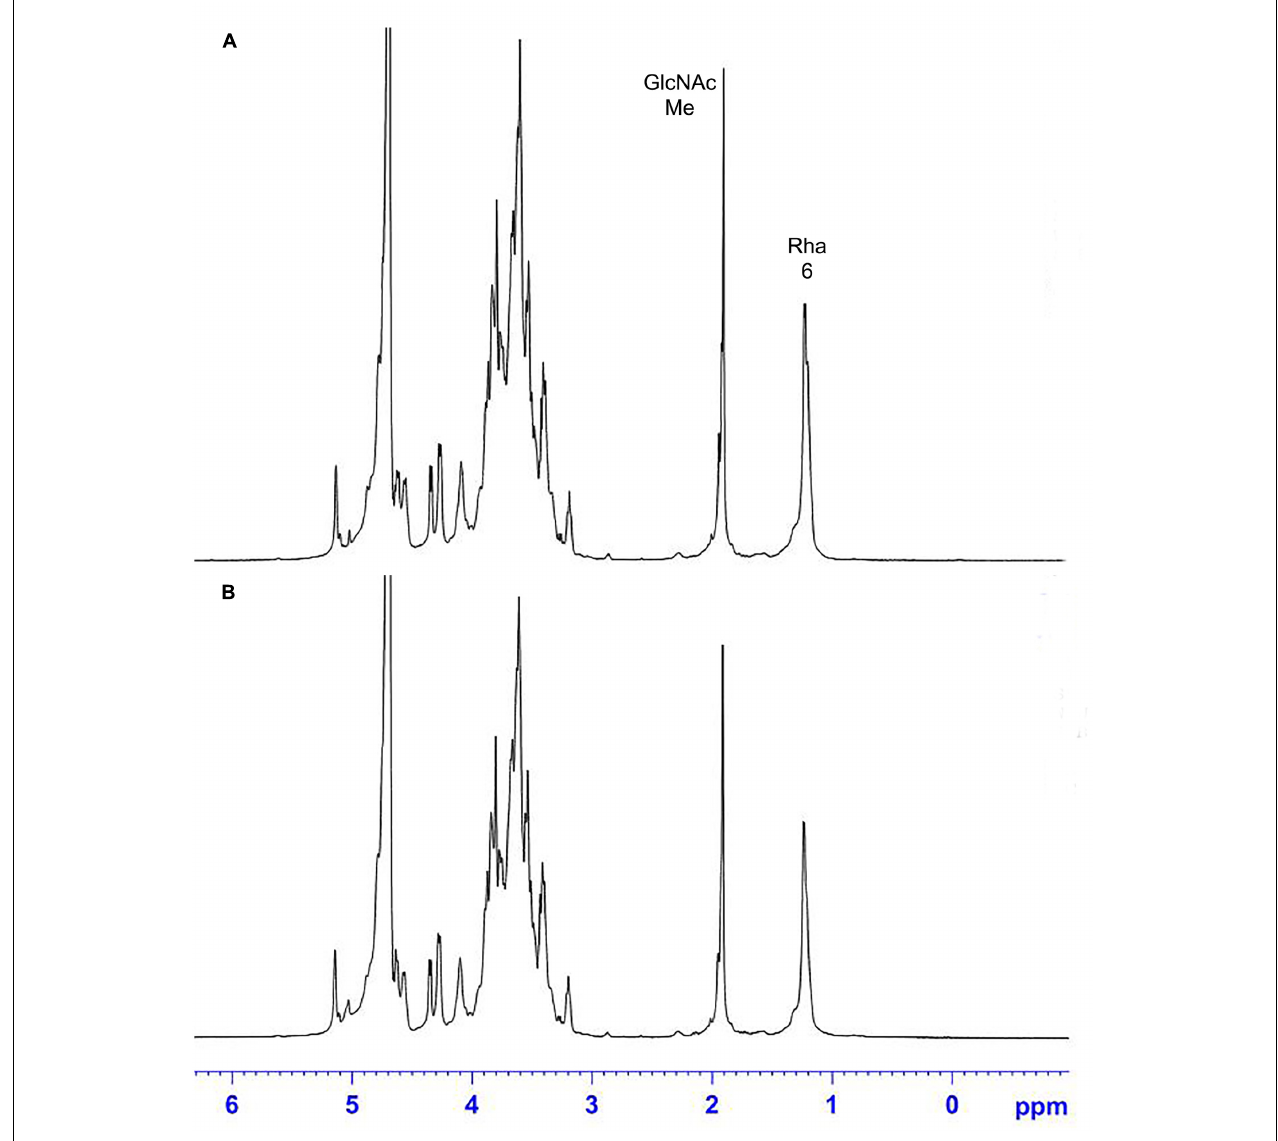
FIGURE 10 | 500 MHz 1 H NMR spectra of desialylated polysaccharide in control (A) and rutin (B) groups.